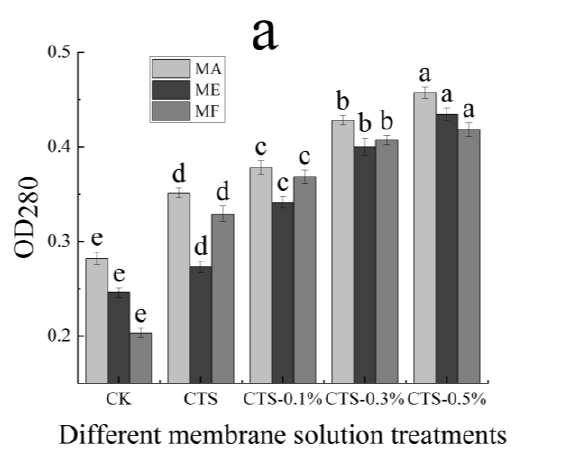
Figure 6. Effect of different concentrations of composite membrane solution on the protein dissolution rate ( a ) and determination of nucleic acids exosmosis ( b ) of mold. The bars on the columns indicate standard deviation. Different letters indicate significant differences ( p < 0.05) within an experiment (marked with letters).